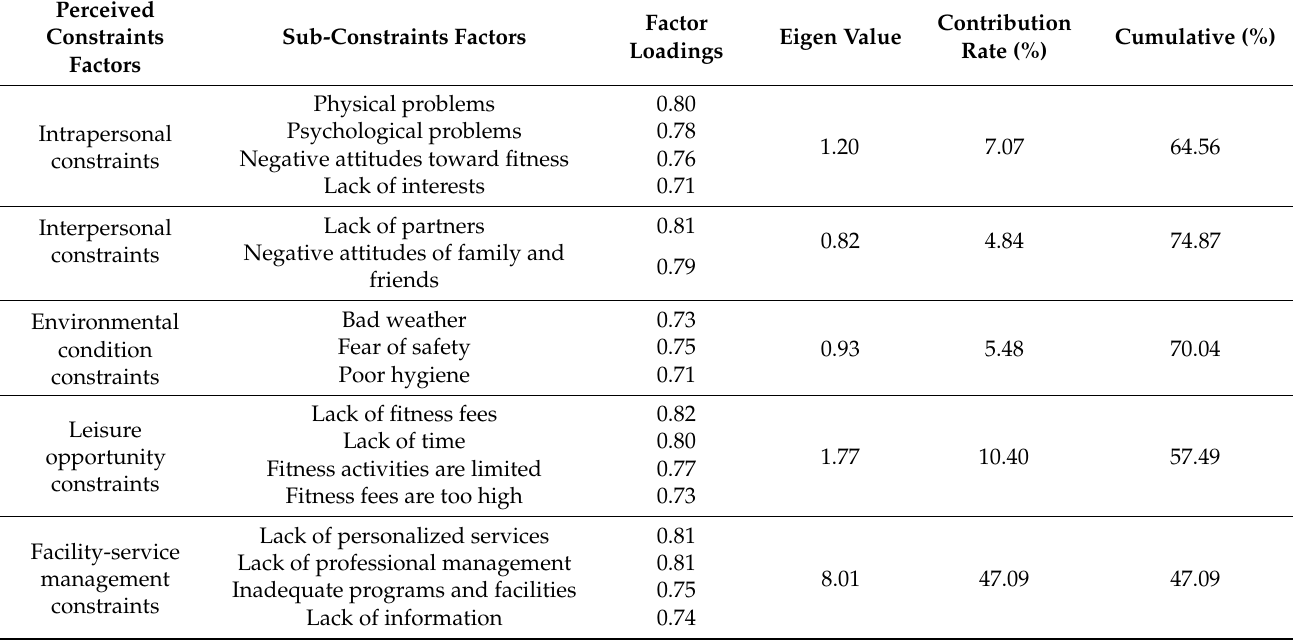
Table 2. The principal component analysis results for 17 items ( n =